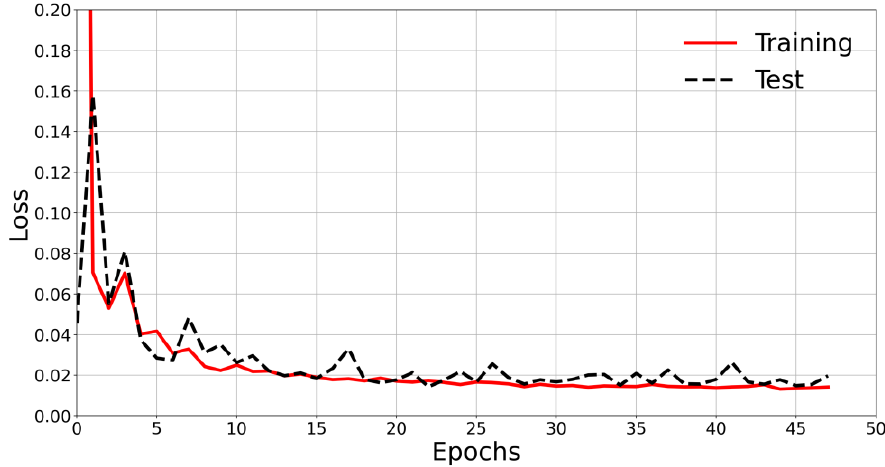
Figure 4. Fuel loss vs. epochs of training and test processes for our developed DNN approach.